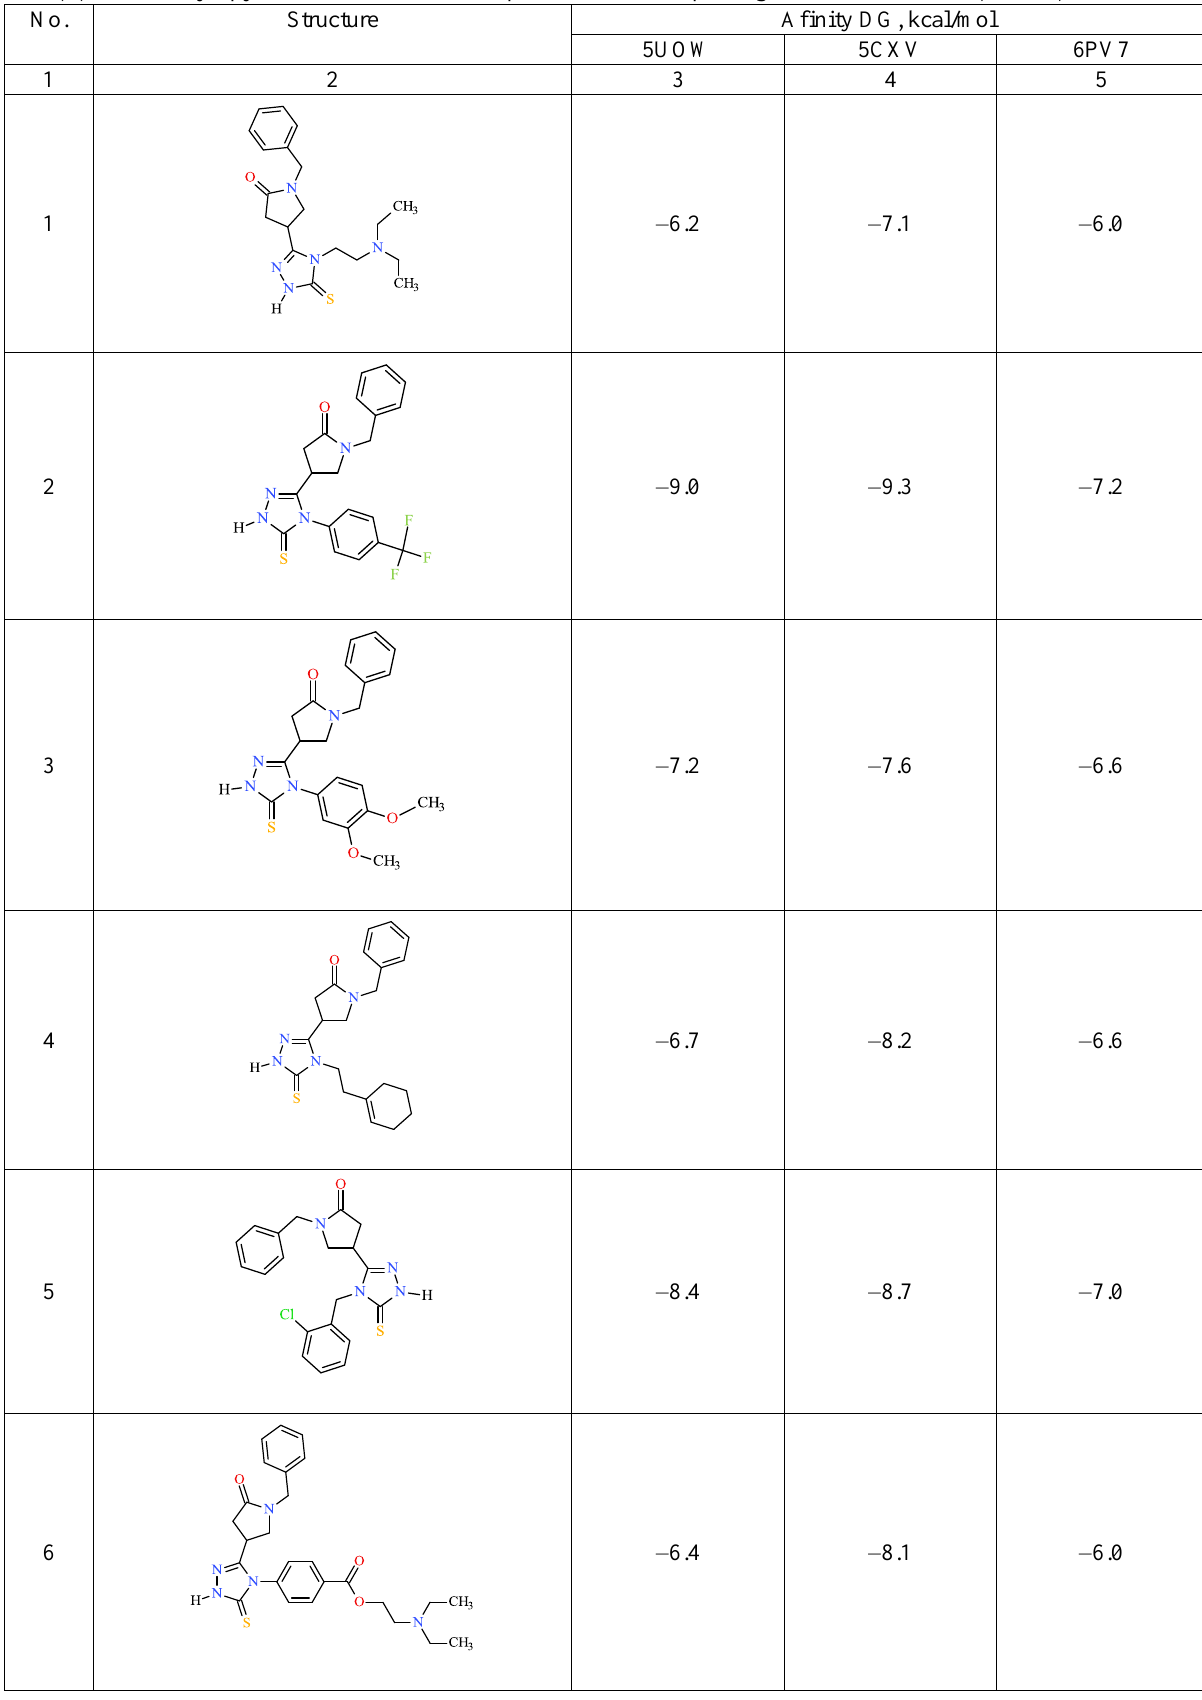
The value of Afinity DG for the best conformational positions of 1-benzyl-4- (4-R-5-sulfonylidene-4,5-dihydro-1H- 1,2,4-triazol-3-yl) pyrrolidin-2-one in the complex with neurotropic targets (PDB ID: 5UOW, 5CXV,